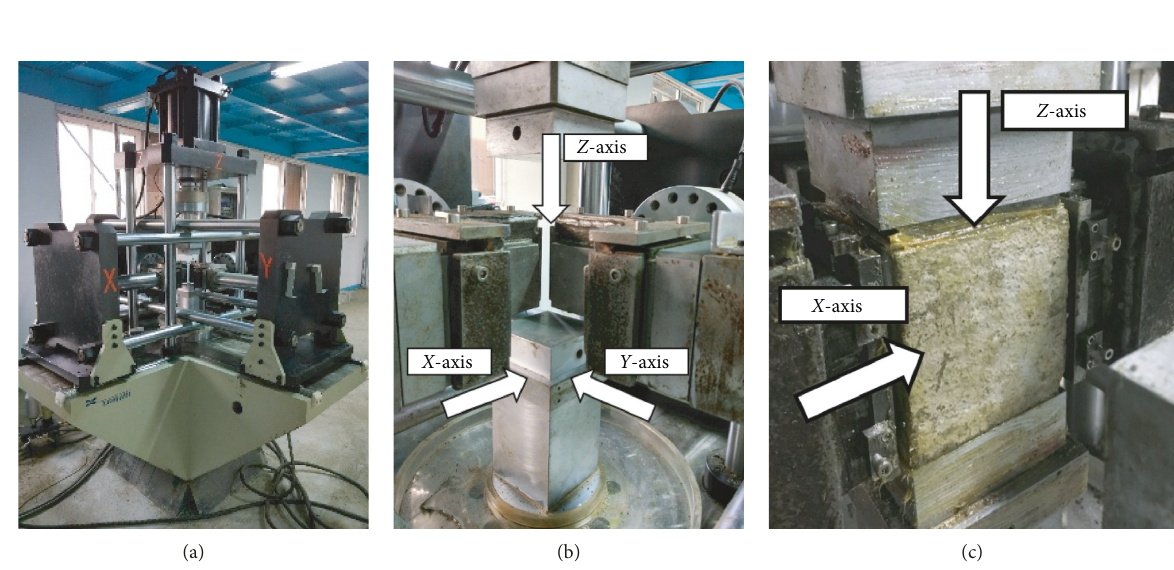
Figure 1: Rock fracture seepage flow testing machine. (a) True triaxial loading device. (b) Schematic diagram of the loading device. (c) Schematic diagram of the specimens’ loading.